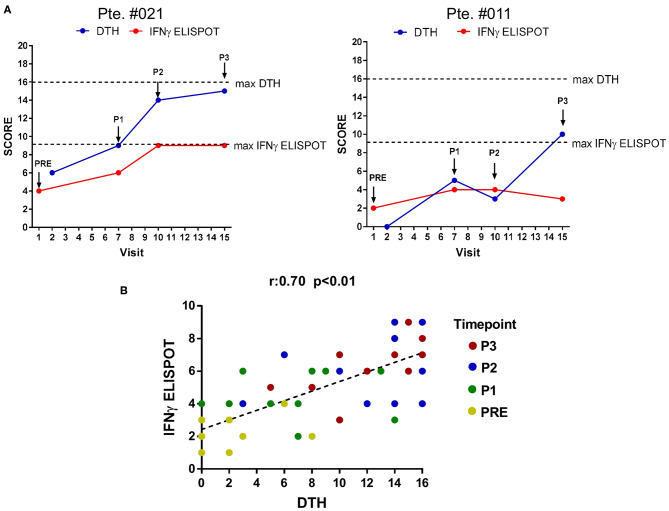
Correlation between DTH and IFNγ-ELISPOT immune response. DTH and IFNγ-ELISPOT score were calculated as described under Methods. (A) DTH and IFNγ-ELISPOT score evolution for two representative patients. Dashed-lines represent highest score value (blue line: DTH score, red line: IFNγ-ELISPOT score). Arrows indicate blood samples timepoints. (B) Global correlation between DTH-score and IFNγ-ELISPOT score of the 13 patients analyzed. Statistically significant correlation was evaluated by Pearson coefficient (r = 0.7; p < 0.01). Different time points are displayed with different colored dots. DTH, delayed-type hypersensitivity test.